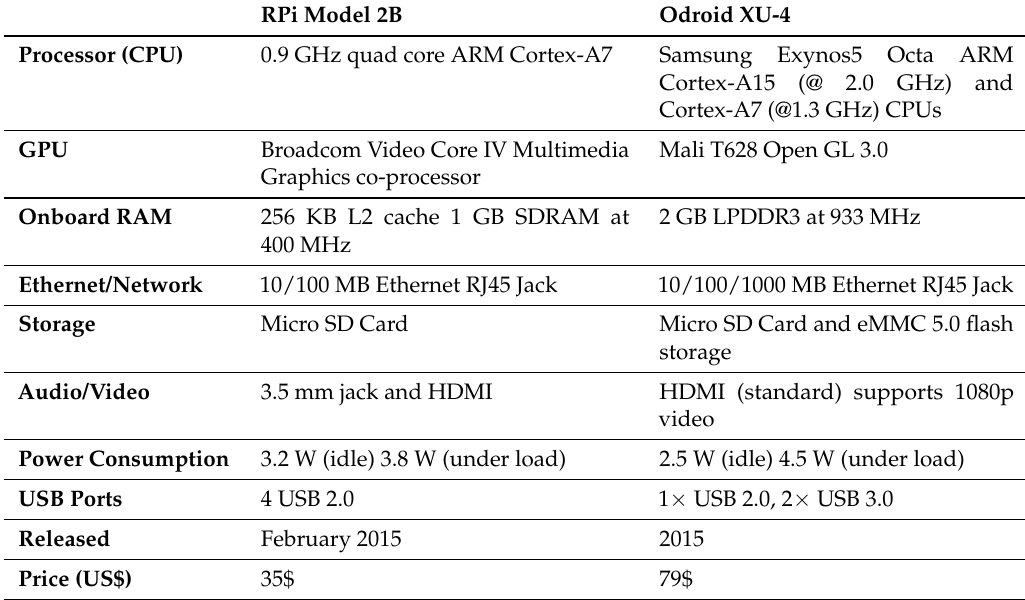
Table 1. Features of Raspberry Pi Model 2B and HardKernel Odroid